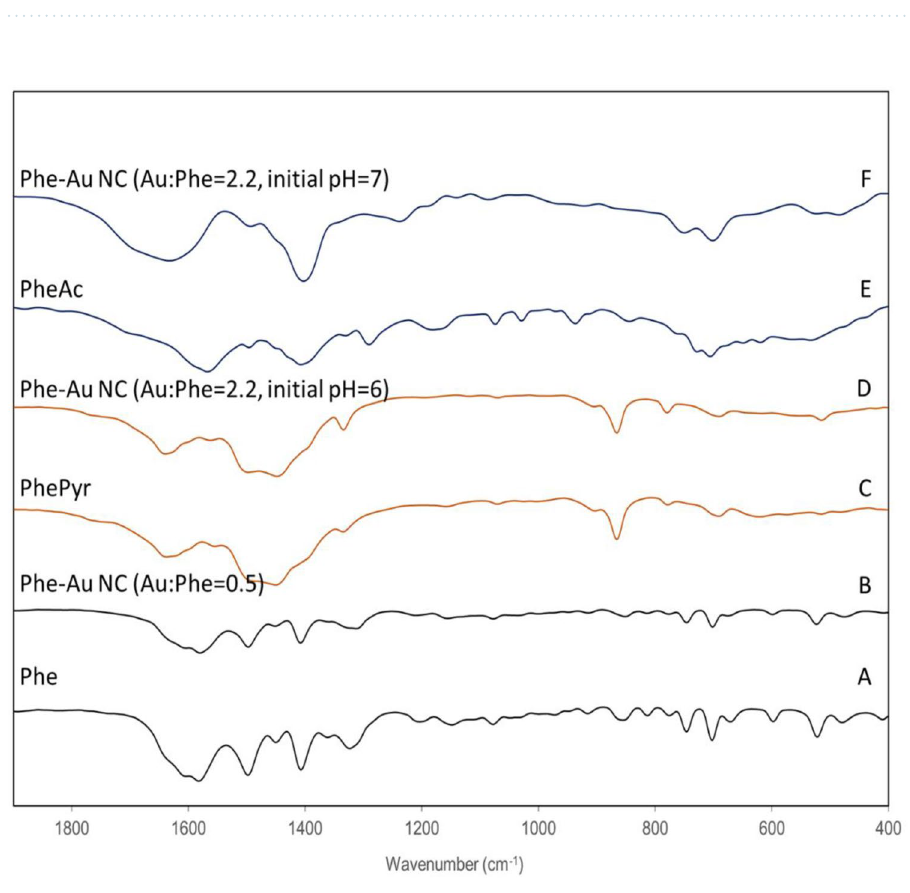
Figure 3. FTIR spectra of Phe, PhePyr, and PheAc that are similar to Phe-AuNCs when Au:Phe = 0.5, Au:Phe = 2.2-initial pH 6, and Au:Phe = 2.2-initial pH 7 respectively, showing the production of PhePyr and